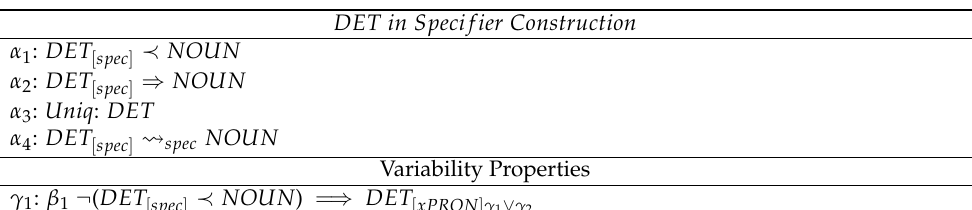
Table A7. Spanish properties of DET